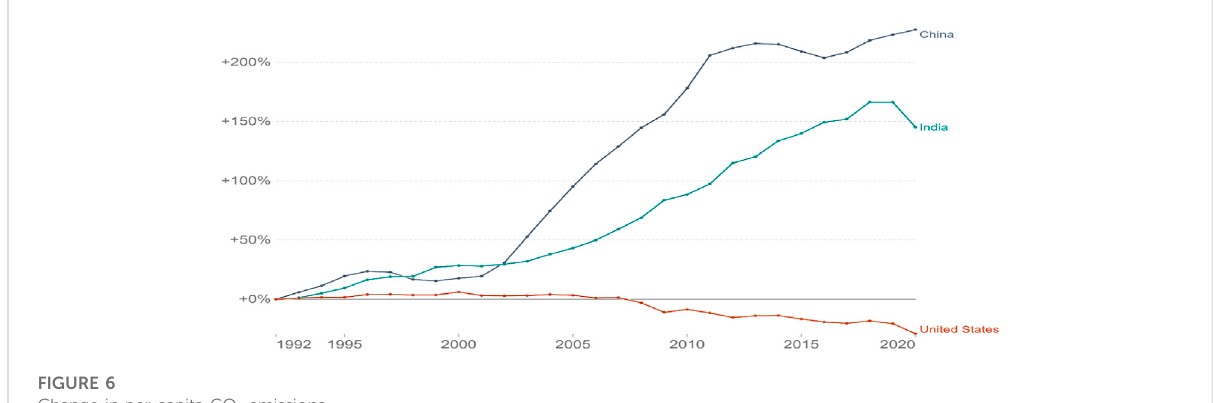
FIGURE 6 Change in per capita CO ₂